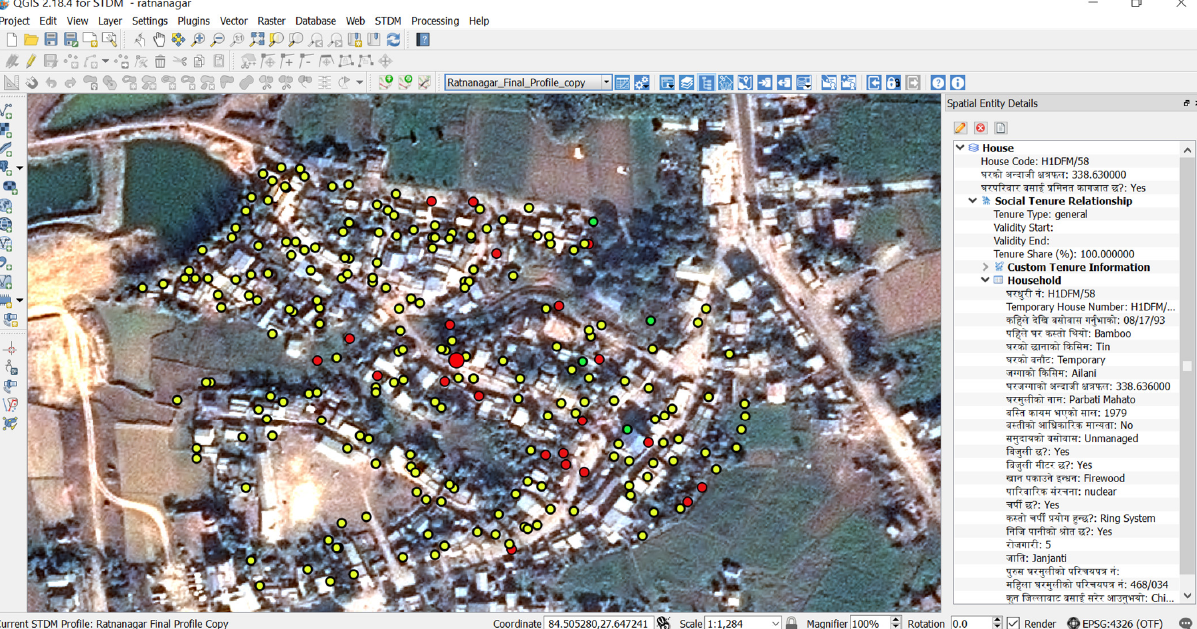
Figure A1. Identification of house/property in one of the compact settlements of Ratnanagar Municipality (shown with red colored dots with satellite imagery in the background; Red, Yellow and Green colored dots respectively represent temporary, semi-permanent and permanent houses) in compact settlements of Ratnanagar Municipality. The right most portion of the picture represents people-to-land relationship’s parameters (in Nepali language) of a select spatial unit (depicted by the enlarged Red colored dot in the center).